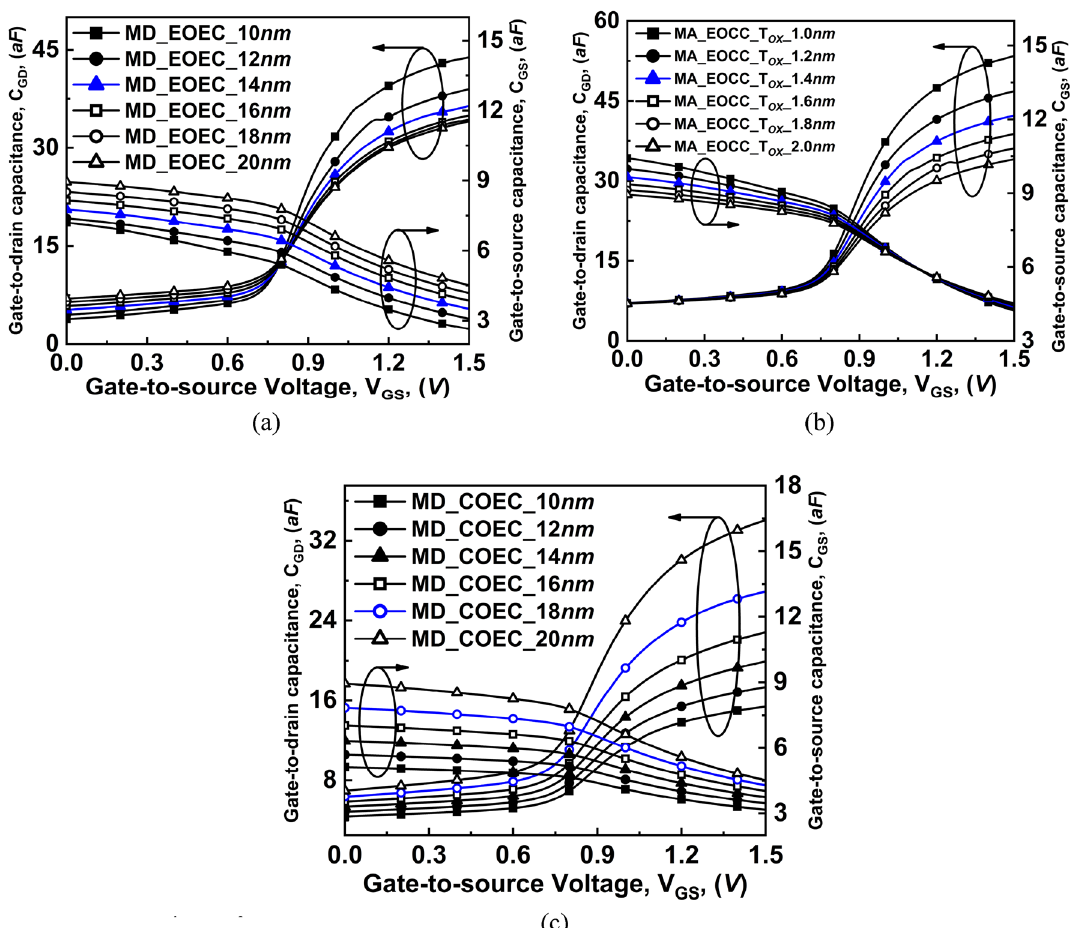
Figure 14. Comparison of variation of gate-to-source capacitances and gate-to-drain capacitances as a function of gate voltage at V DS = 0.3 V of COCC structure with ( a ) EOEC, ( b ) EOCC, and ( c ) COEC